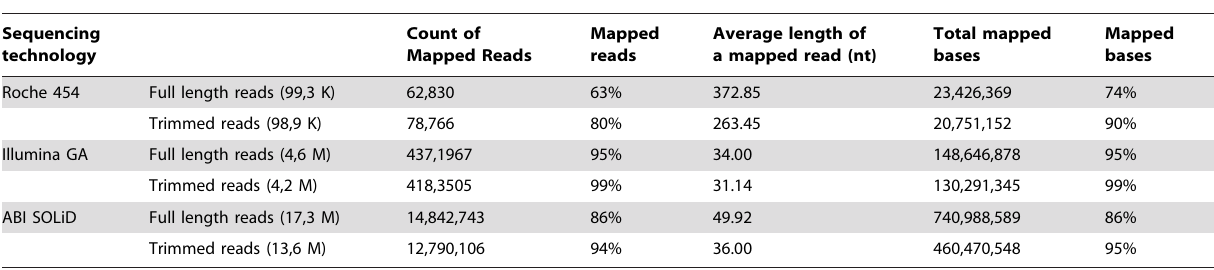
Table 2. Features of reads mapping to the 31-kb reference sequence.